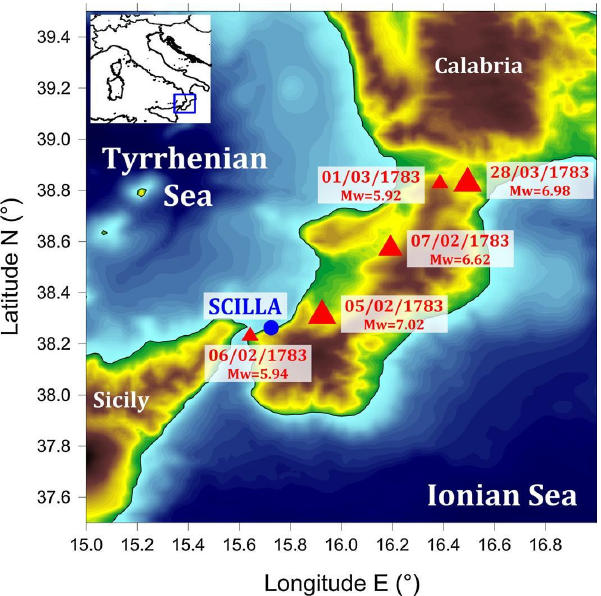
Figure 1. Epicenters (red triangles), dates and magnitudes of the five strongest earthquakes affecting Calabria during 1783 (Zaniboni et al.,